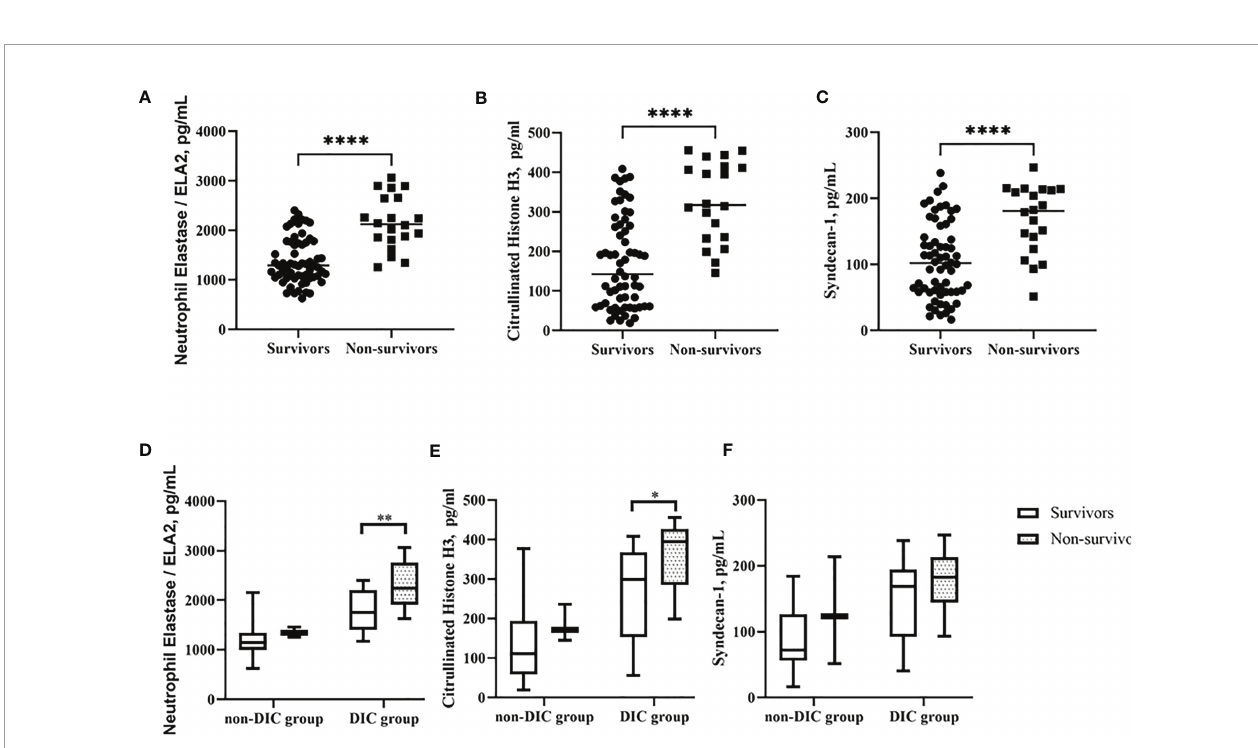
FIGURE 4 | Comparison of NETs level in different groups. (A – C) ELA2, H3 and Syndecan-1 levels in groups of survivor and non-survivor patients. (D – F) ELA2, H3 and Syndecan-1 levels in groups of patients with or without DIC strati fi ed by 28-day mortality. *p < 0.05, **p < 0.01, ****p <